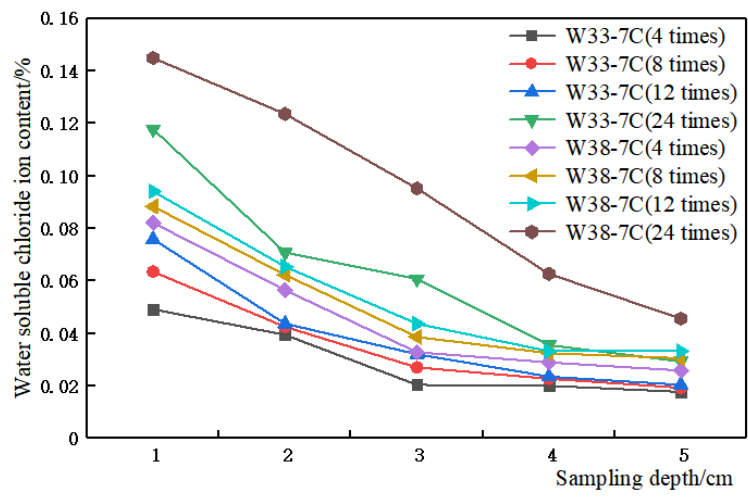
Figure 4. Changes in Cl − permeation in concrete with different Cl − concentrations. W33-7L and W38-7L in Figures 5 and 6 used tensile stress shelves, applying 40% of the ultimate tensile stress. The results show that the Cl − concentration in each layer of concrete gradually increased with an increase in the number of cycles. The Cl − content in specimens with a low W/C ratio (0.33) was less than that in specimens with a high W/C ratio (0.38) with the same number of cycles.